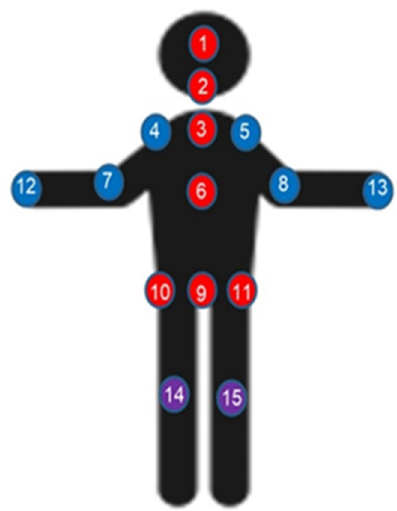
Figure 1. Joint annotation of the human body.